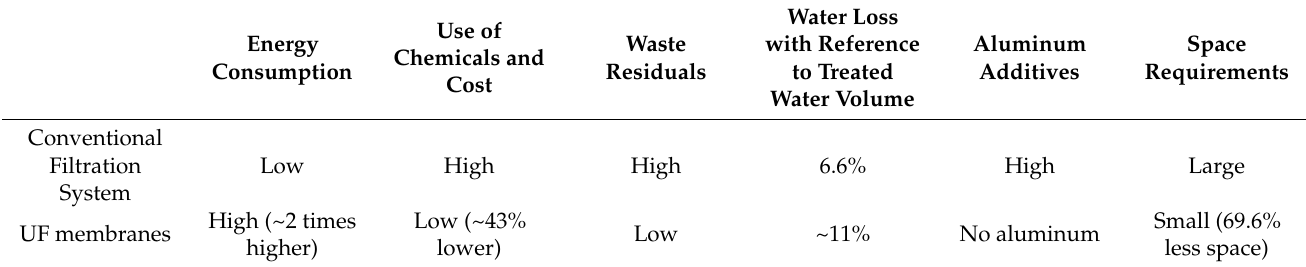
Table 1. Summary of environmental impacts for water treatment with conventional filtration system and ultrafiltration membranes.